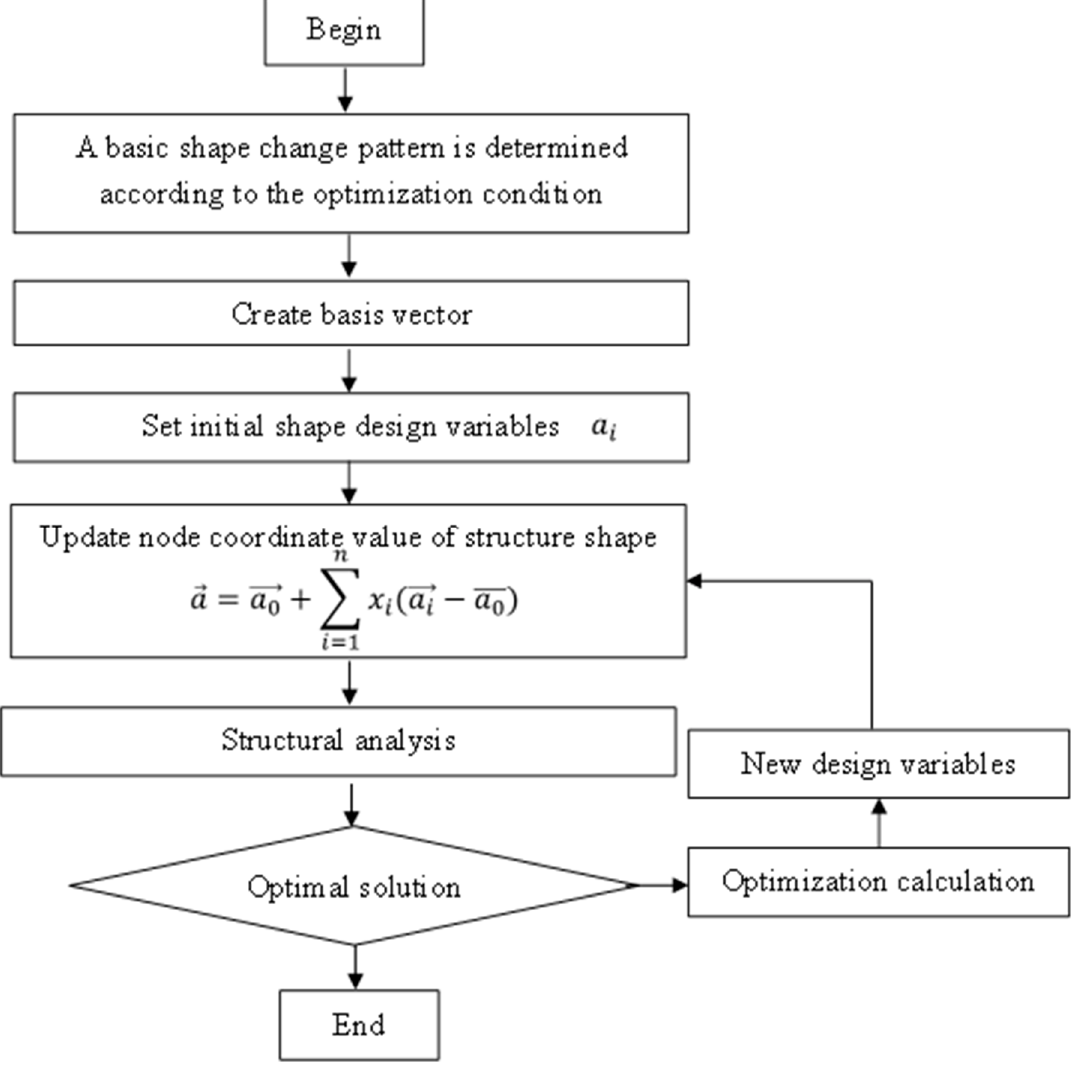
Figure 4. Flow chart of the shape optimization process.